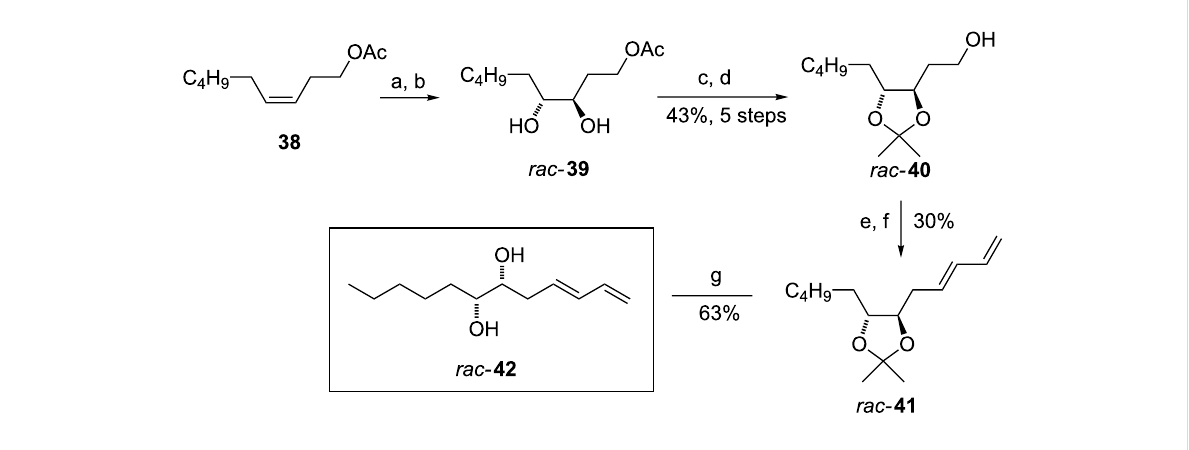
Scheme 5: Synthesis of rac - 42 . Reagents and conditions: a) MCPBA, CH 2 Cl 2 , 0 °C to rt, 45 min; b) TFA, H 2 O, THF, 60 °C overnight, c) acetone, PTSA, 3 h, rt; d) NaOMe, MeOH, 48 h, rt, 43% over 5 steps; e) (COCl) 2 , DMSO, Et 3 N, CH 2 Cl 2 , − 78 °C to rt, 2 h; f) diethyl allylphosphonate, BuLi,